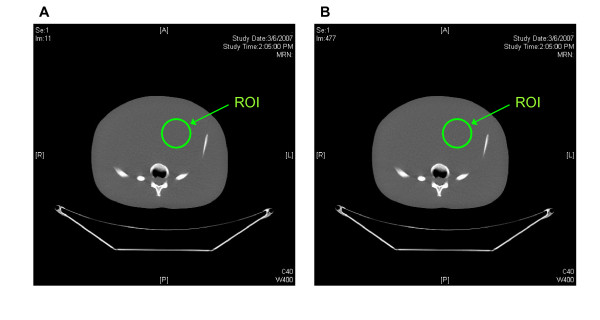
Comparison of abdominal CT images. Abdominal CT images of Humanoid phantom both (A) with and (B) without the gonad shield in place. An identical region of interest (ROI), as indicated by the circle, was selected on each image to measure noise.